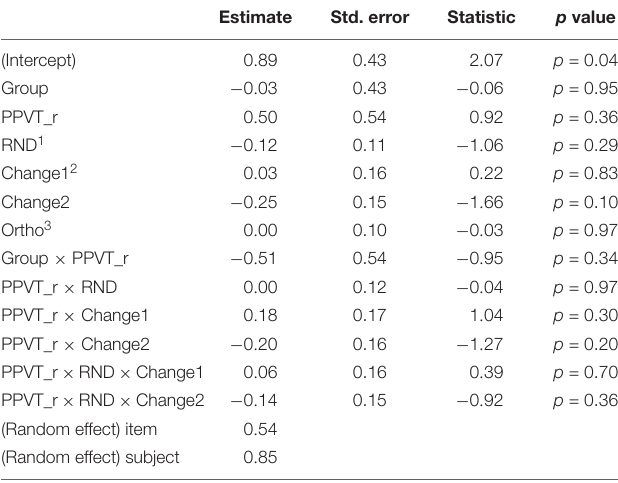
TABLE 8 | Regression results for linguistic characteristics.